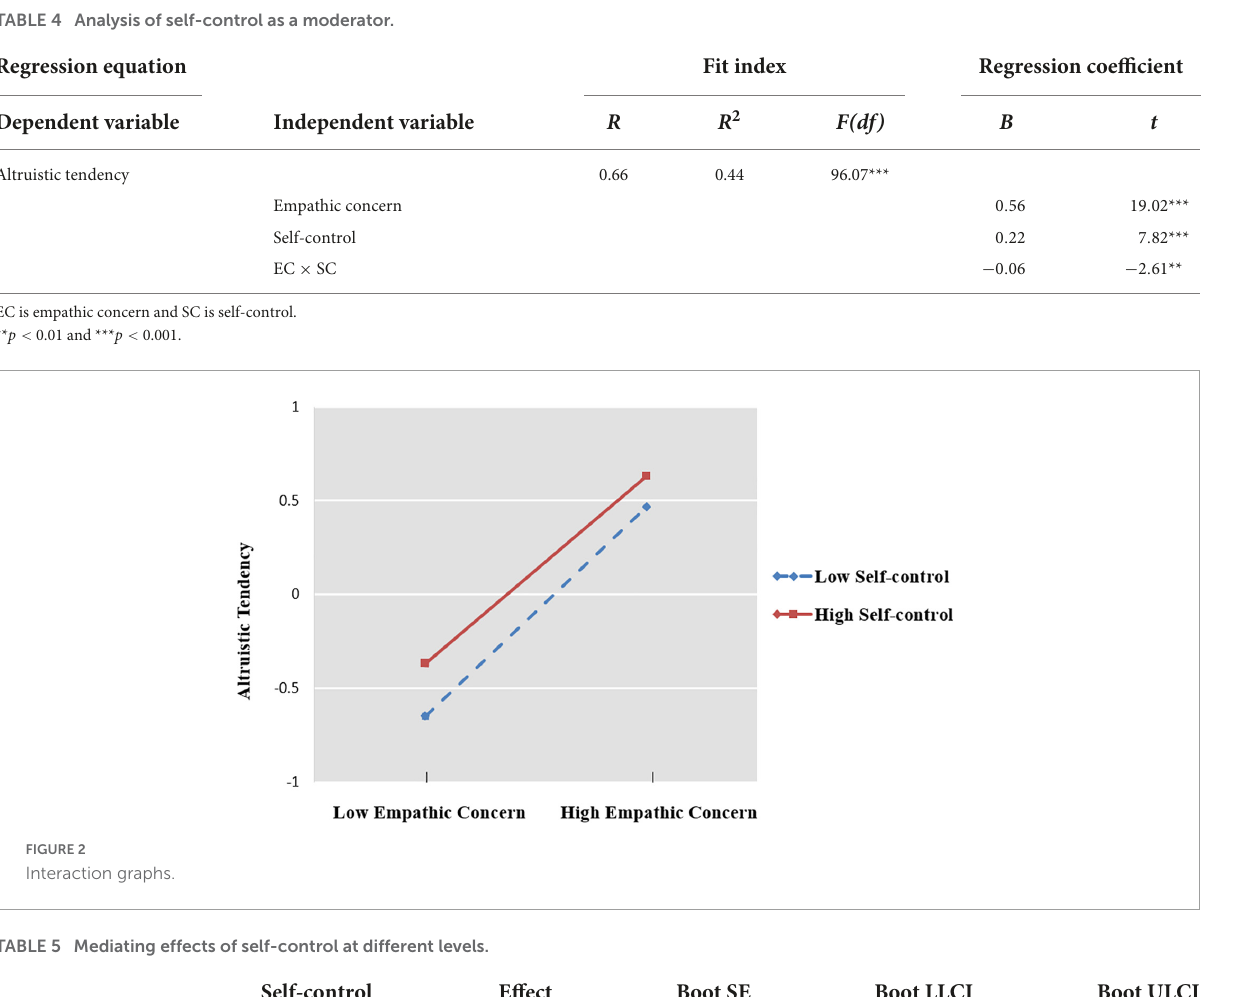
TABLE 4 Analysis of self-control as a moderator.